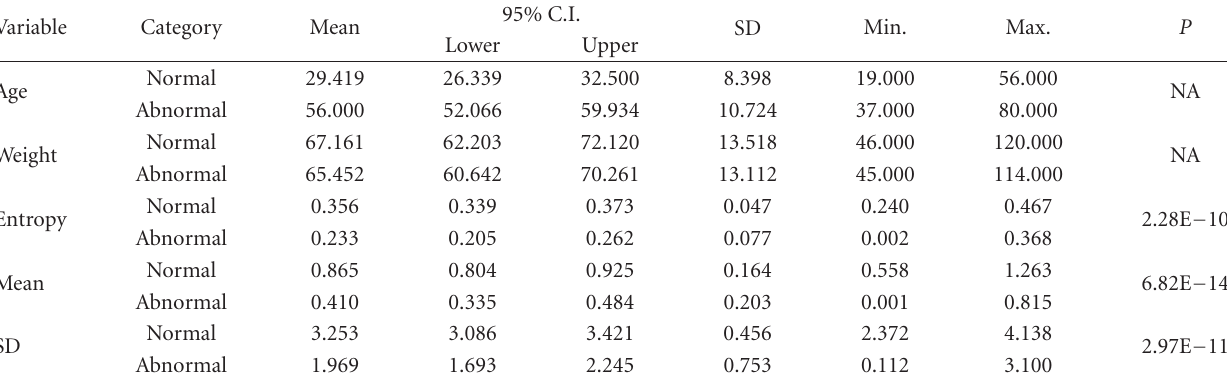
Table 2: Descriptive statistics of age, body weight, and extracted features (SD, mean, and entropy of pixel intensity in the ROI). P values from t -test reveal statistically significant di ff erences between extracted features of images of normal and abnormal groups. Variable